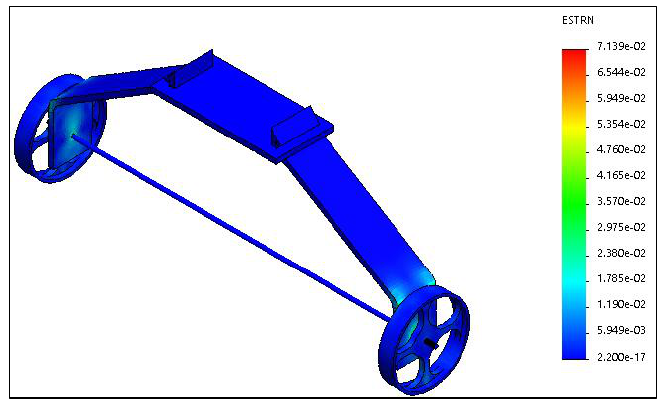
Figure 10: Result of deformation analysis in the Drop test. Source: Authors,